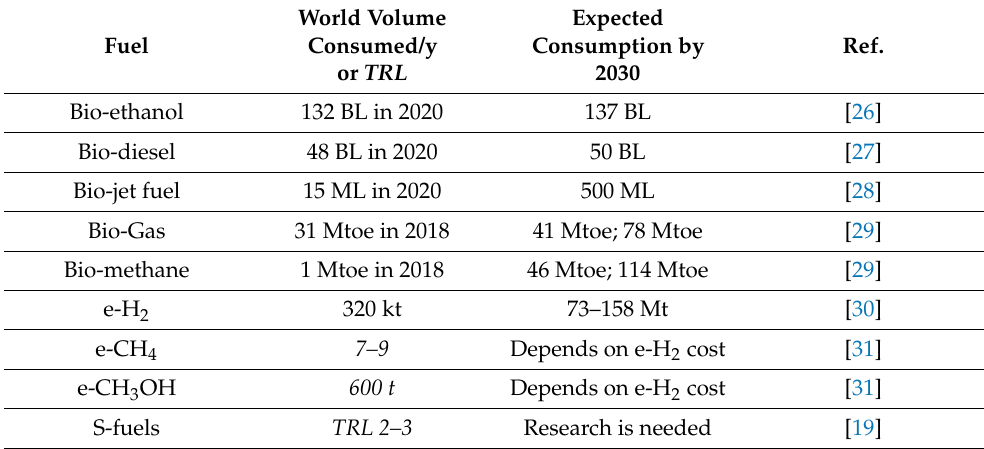
Table 3. Potential of biofuels and E-fuels as substitutes of fossil C-derived